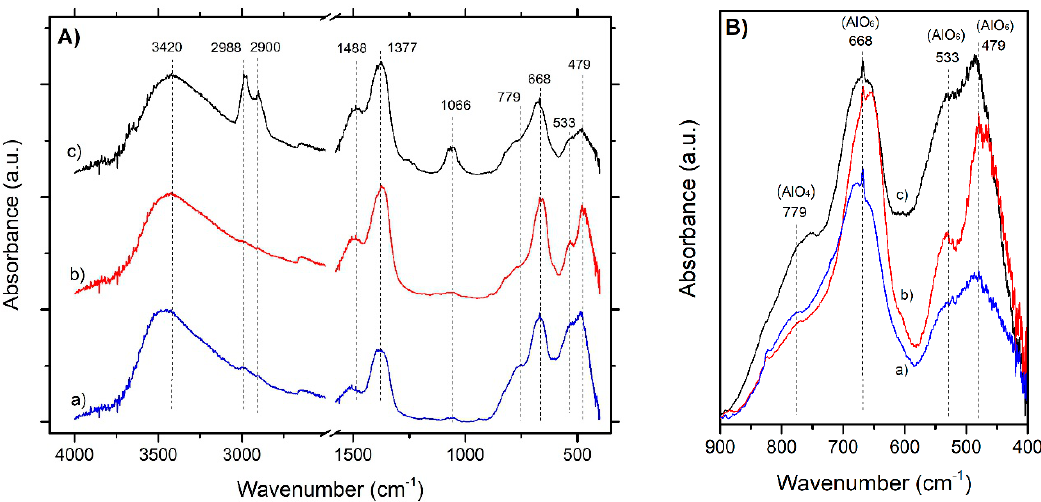
Figure 4. ( A ) FT-IR spectra of ZnAl_X_K catalysts with different Zn/Al molar ratios. (a) ZnAl_0.3_K, (b) ZnAl_0.5_K, (c) ZnAl_1.0_K. ( B ) The presence of bands characteristic of tetrahedral aluminum (AlO 4 ) and octahedral aluminum (AlO 6 ).